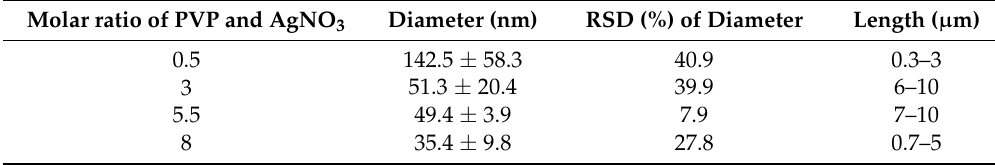
Table 1. Mean diameter and length of the as-obtained silver nanowires or silver nanorods. Molar ratio of PVP and AgNO 3 Diameter